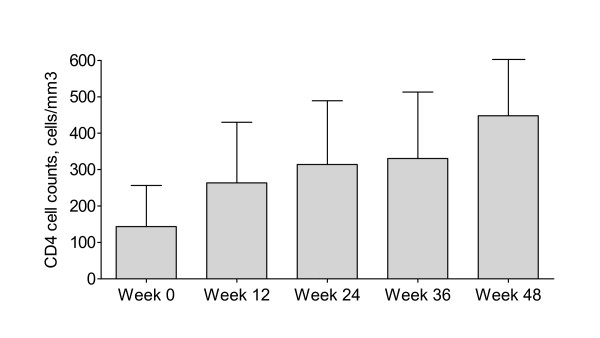
Means and its standard deviations of CD4 cell counts changes at weeks 12, 24, 36 and 48 of treatment.